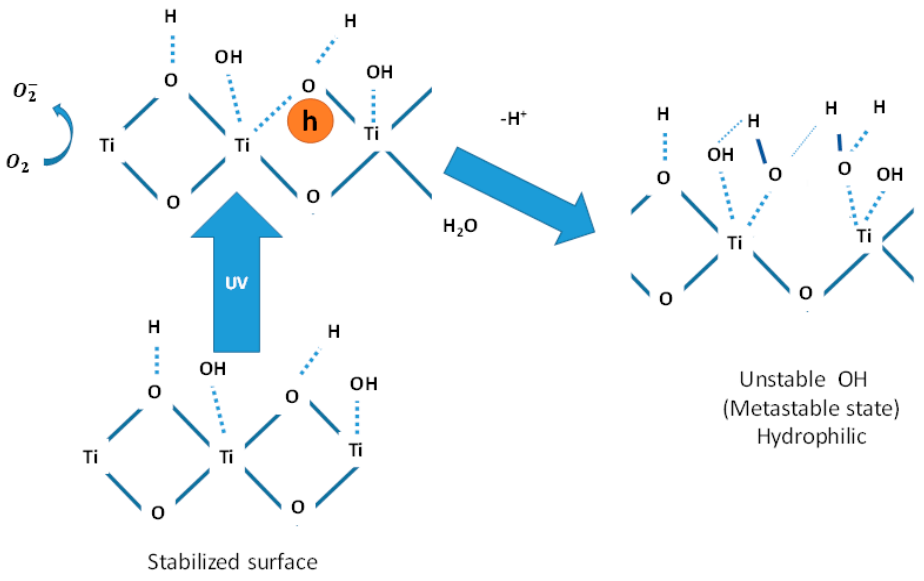
Figure 7. Mechanism of surface wettability of TiO 2 film under UV light irradiation.